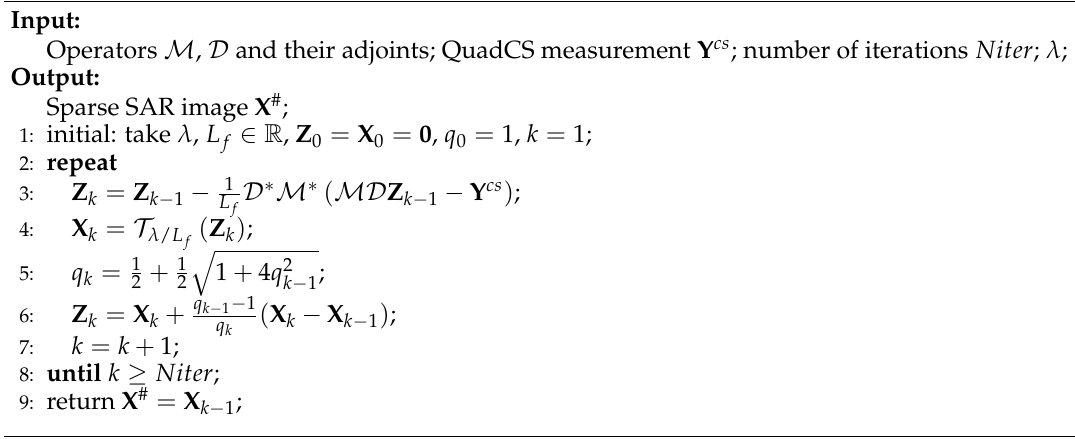
Algorithm 1 Fast sparse imaging with QuadCS